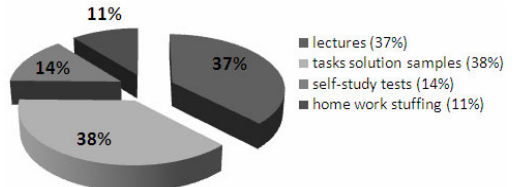
Figure 8. Types of ORTUS teaching materials used in the learning process